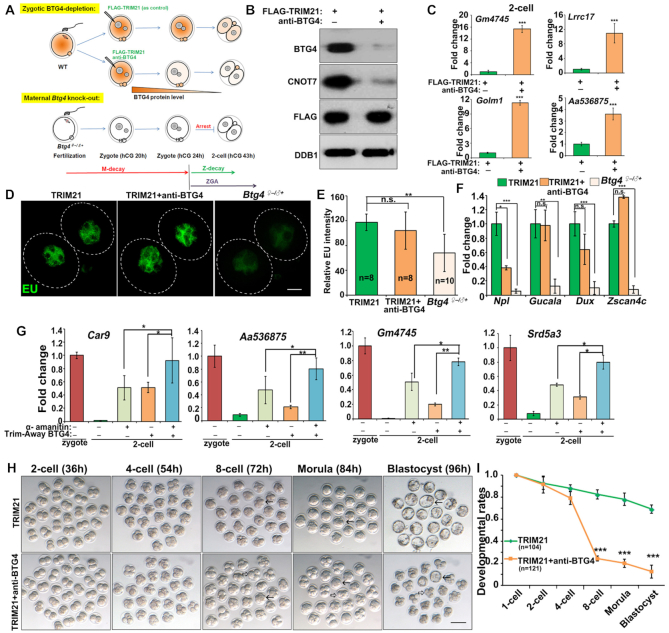
Dynamics of 3′-terminal polyadenylation and oligouridylation in maternal transcripts undergoing M-decay and Z-decay. (A) Illustration of BTG4 Trim-Away experiments. Zygotes were collected from in vivo at 20 h after hCG injection and were co-injected with Flag-Trim21 mRNA and anti-BTG4 antibody or were only injected with Flag-Trim21 mRNA as a negative control. Microinjected zygotes were cultured for another 4 h before sample collection for western blotting. (B) Western blot results showing the levels of BTG4, CNOT7, and TRIM21. Total proteins were collected from 100 zygotes at 4 h after microinjection and were loaded in each lane. DDB1 was blotted as a loading control. (C) RT-qPCR results showing the relative mRNA levels of indicated Z-decay transcripts in two-cell embryos with or without BTG4 Trimming-away. Error bars, s.e.m. ***P < 0.001 by two-tailed Student's t-test. n = 3 biological replicates. (D and E) Immunofluorescence (D) and quantification (E) of 5-ethynyl uridine (EU) fluorescence showing RNA transcription in two-cell embryos with or without BTG4 Trimming-away, and in maternal Btg4 knockout two-cell embryos. Scale bar, 20 μm. Error bars, s.e.m. n.s.: non-significant. **P < 0.01 by two-tailed Student's t-test. (F) RT-qPCR results showing the relative mRNA levels of indicated zygotic transcripts in two-cell embryos with or without BTG4 Trimming-away. Error bars, s.e.m. n.s.: non-significant. *P < 0.05 and ***P < 0.001 by two-tailed Student's t-test. n = 3 biological replicates. (G) RT-qPCR results showing the relative mRNA levels of indicated transcripts in zygote and two-cell embryos with or without BTG4 Trim-away and α-amanitin treatment. Error bars, s.e.m. n.s.: non-significant. *P < 0.05 and ***P < 0.001 by two-tailed Student's t-test. n = 3 biological replicates. (H-I): Developmental rates (H) and Representative images (I) of preimplantation embryos after zygotic BTG4-depletion. Time after hCG injection (h) and numbers of analyzed embryos are indicated (n). Zygotes were microinjected as in (A), and then cultured until 96 h after hCG injection. Error bars, s.e.m. ***P < 0.001 by two-tailed Student's t-test. Scale bar, 100 μm. Arrows and hollow arrows indicate the normal embryos and arrested embryos, respectively.